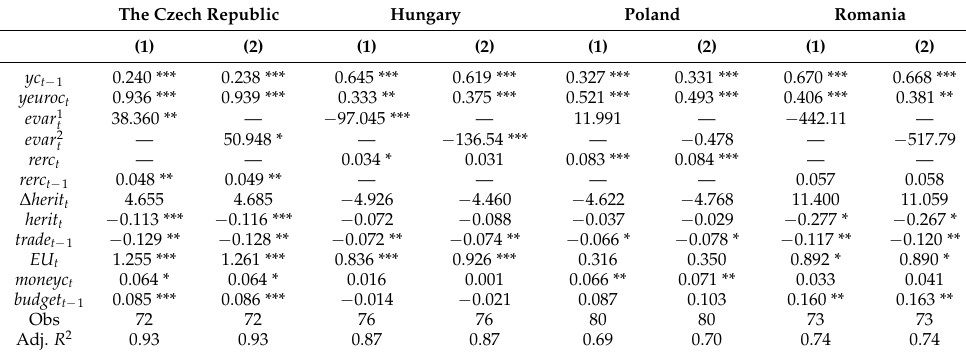
Table 6. Regression results for cyclical components of output (extended